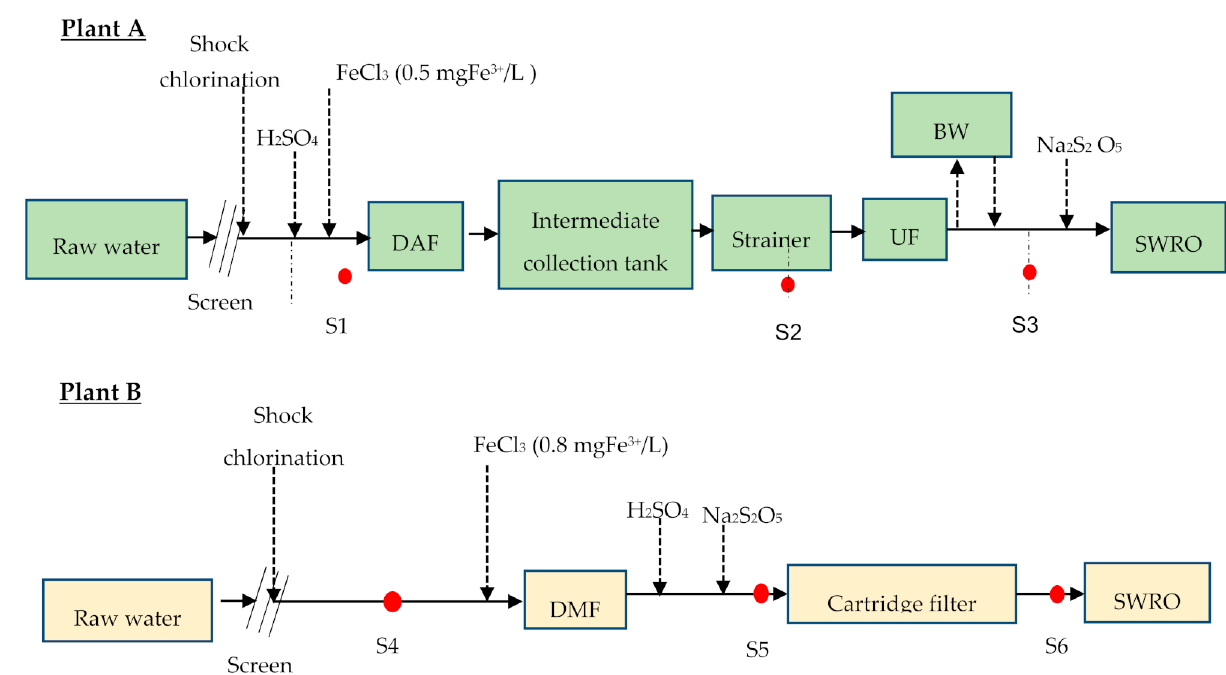
Figure 2. General scheme of ( A ) the dissolved air flotation/ultrafiltration/reverse osmosis (DAF–UF–RO) plant and ( B ) the dual media filtration/cartridge filter/reverse osmosis (DMF–CF–RO) plant (red dots are sampling points).